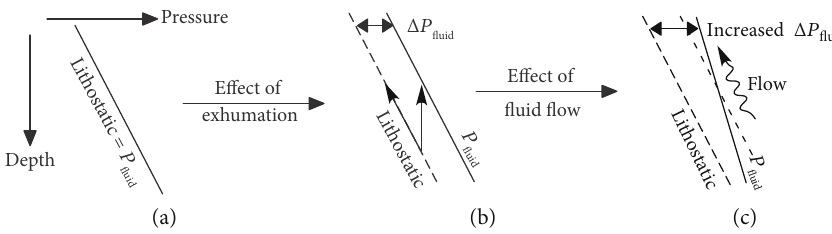
Figure 4: Fluid overpressure resulting from exhumation and fl uid fl ow. (a) Initial situation where fl uid pressure equals lithostatic pressure. (b) For a given rock volume, exhumation results in an upward shift along the lithostatic pressure gradient. Trapped pore fl uid maintains its pore pressure and becomes overpressured. (c) Fluid fl ow will lead to a decrease of the fl uid pressure gradient, increasing the overpressure downstream.